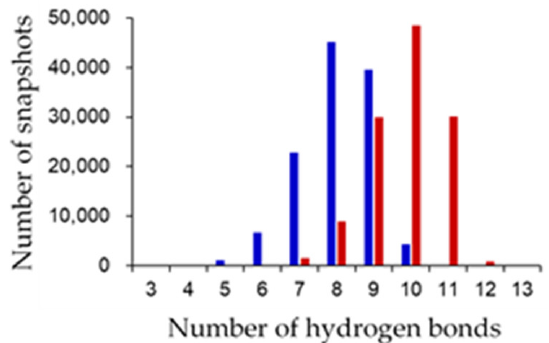
Figure 7. Distribution of the number of [NH . . . S] and [OH . . . S] hydrogen bonds. The number of hydrogen bonds in the oxidized and reduced forms are represented in blue and red, respectively.